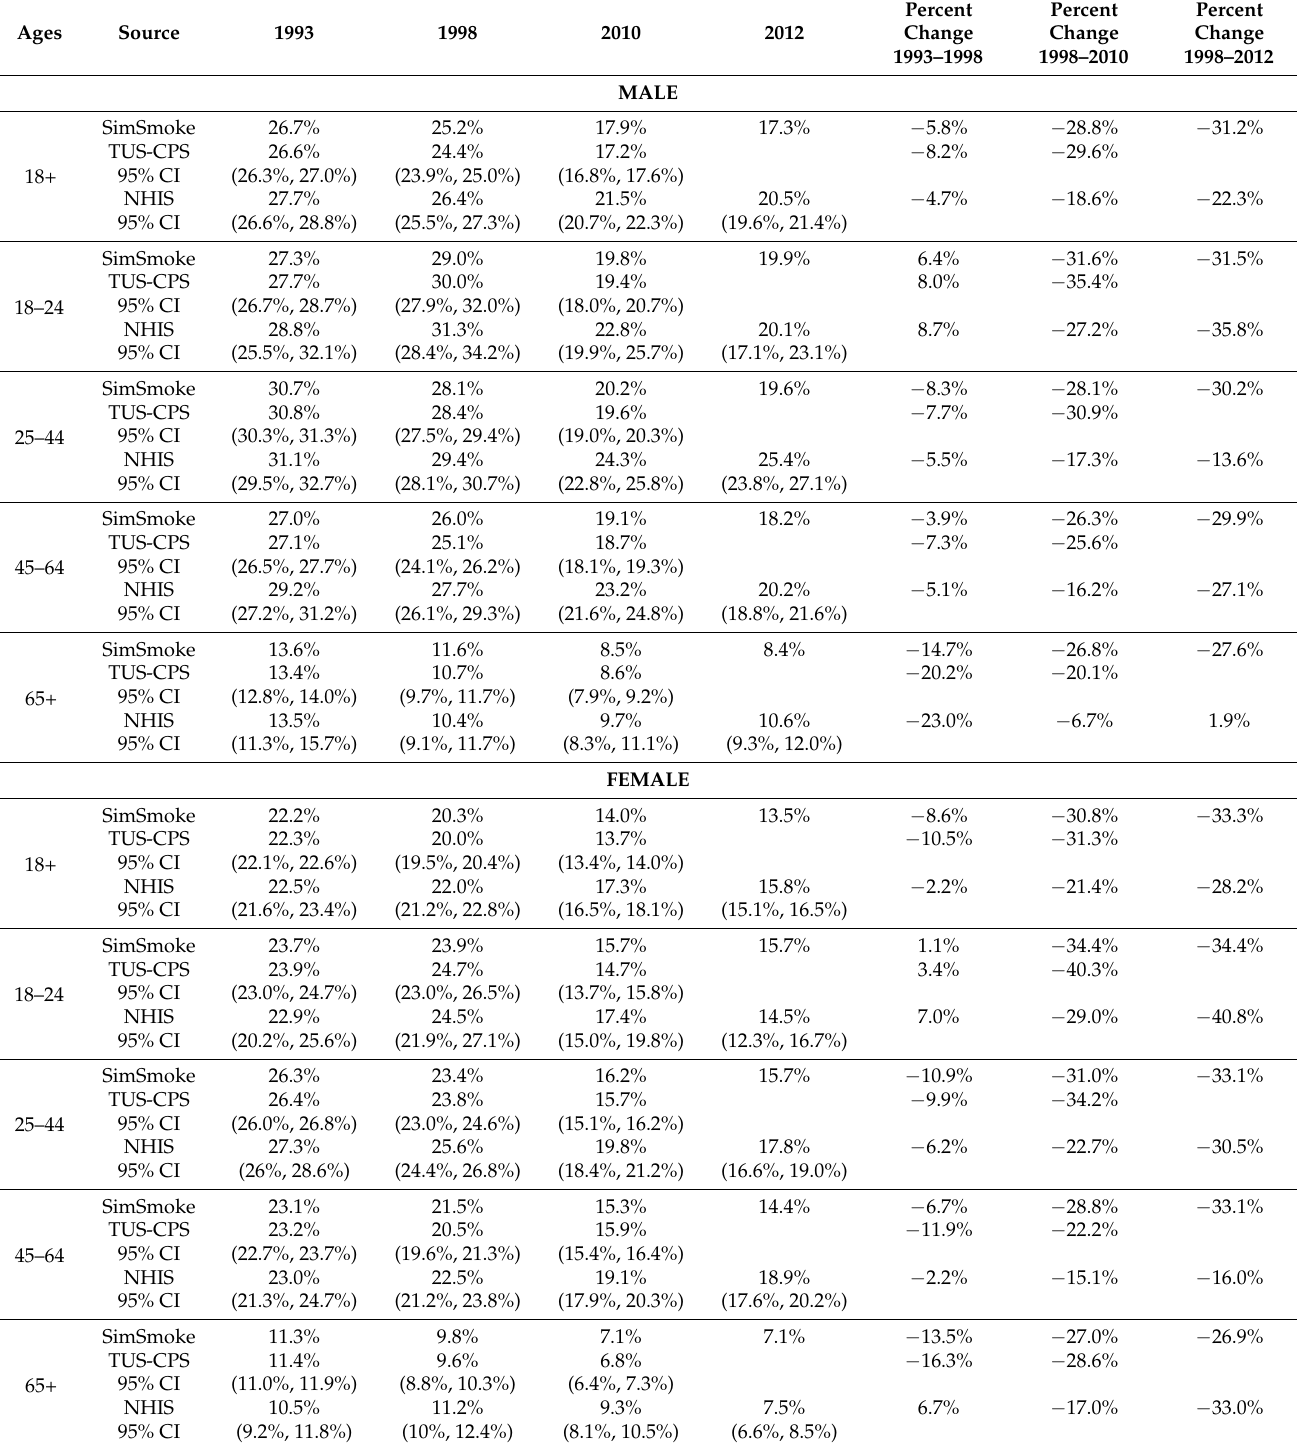
Table 2. Calibration and validation of US SimSmoke current smoking prevalence predictions against national surveys, by age and gender,